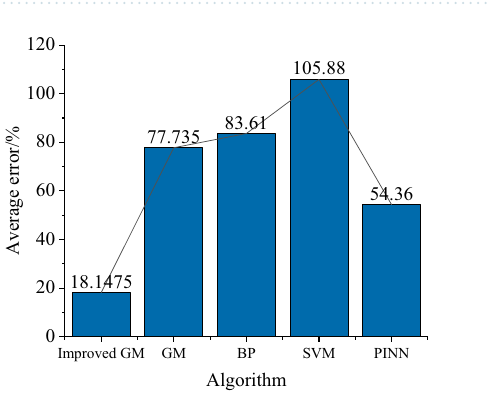
Table 2. Error analysis of data predicted by different models.